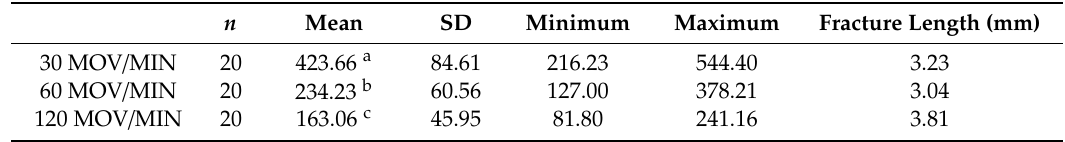
Table 1. Descriptive statistics of the time to